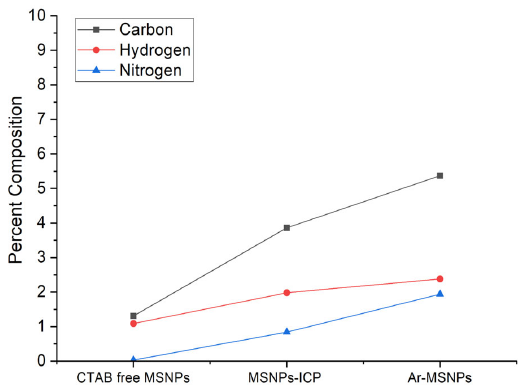
Figure 2. The chemical compositions of CTAB free MSNPs, MSNPs-ICP, and Ar-MSNPs quantified by elemental analysis.